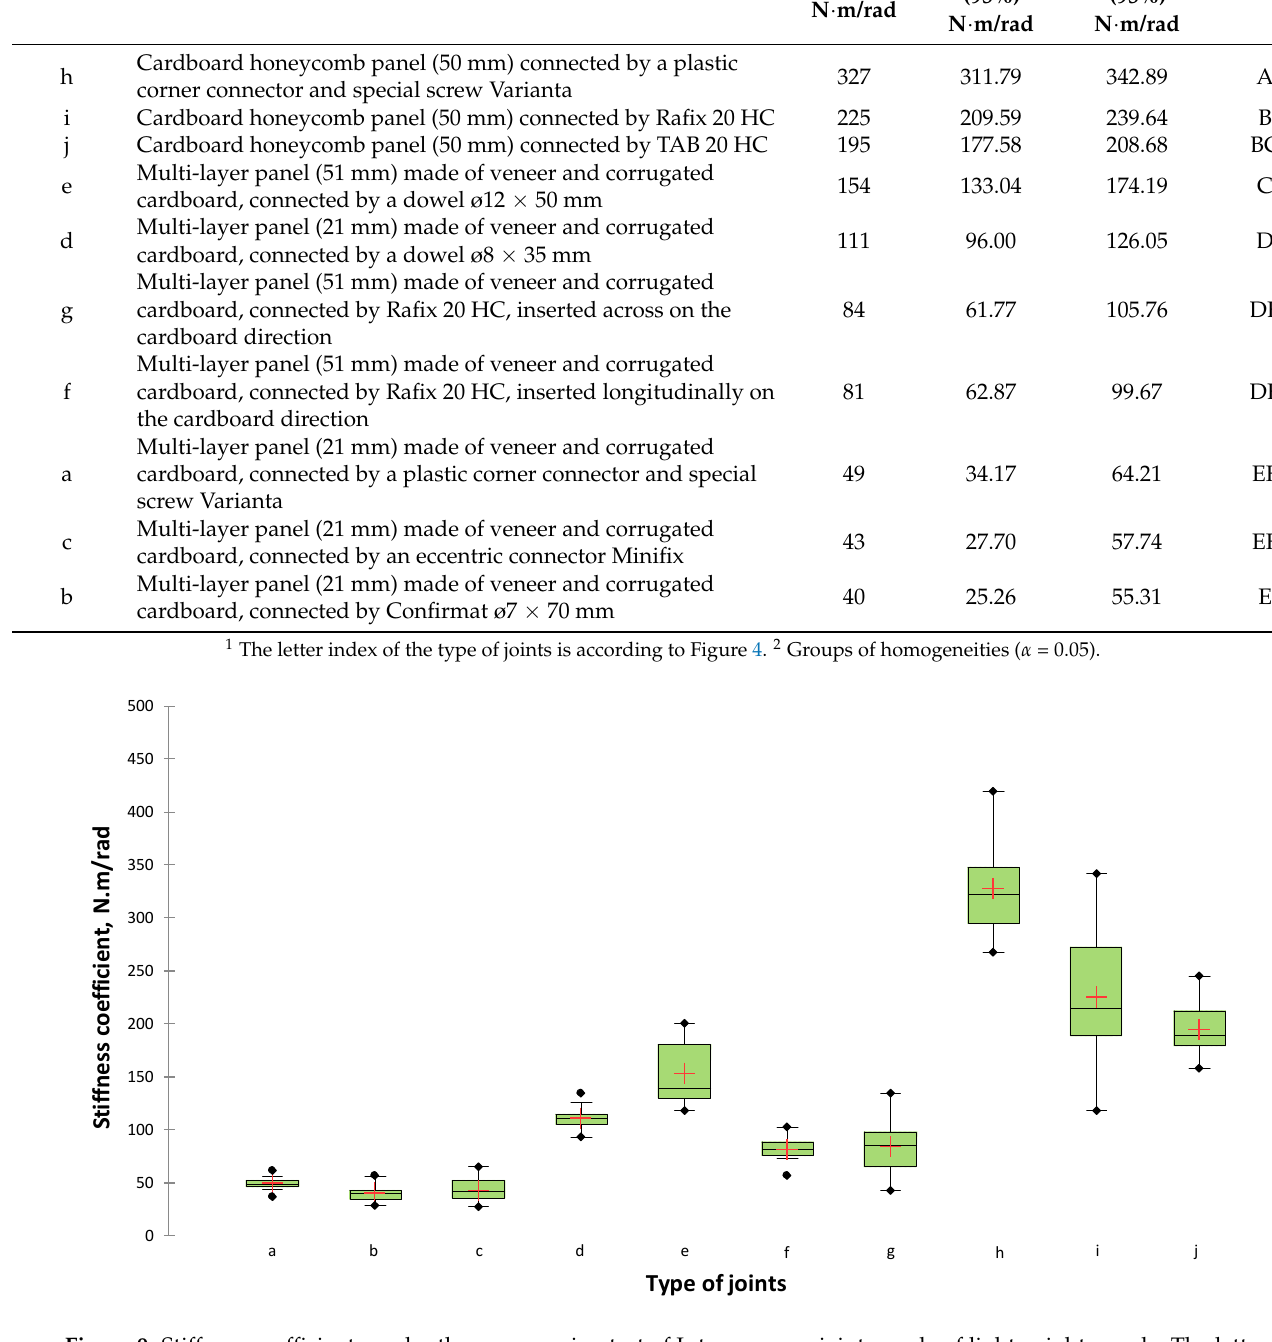
Figure 9. Stiffness coefficients under the compression test of L-type corner joints made of lightweight panels. The letter index of the type of joints is according to Figure 4. Table 5. Tukey HSD analysis of the differences between the groups with a confidence interval of 95% of stiffness coeffi- cients of joints of two materials of all pairwise comparisons.